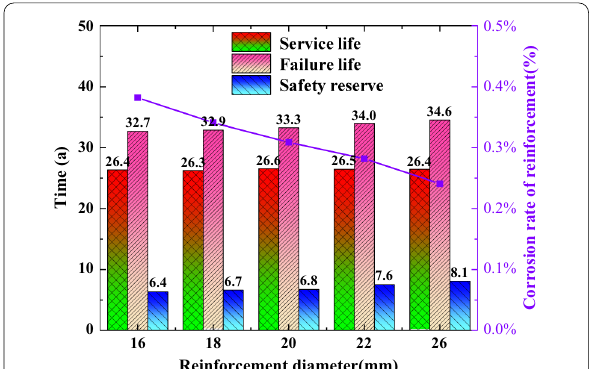
Fig. 9 Effect of rebar diameter on service